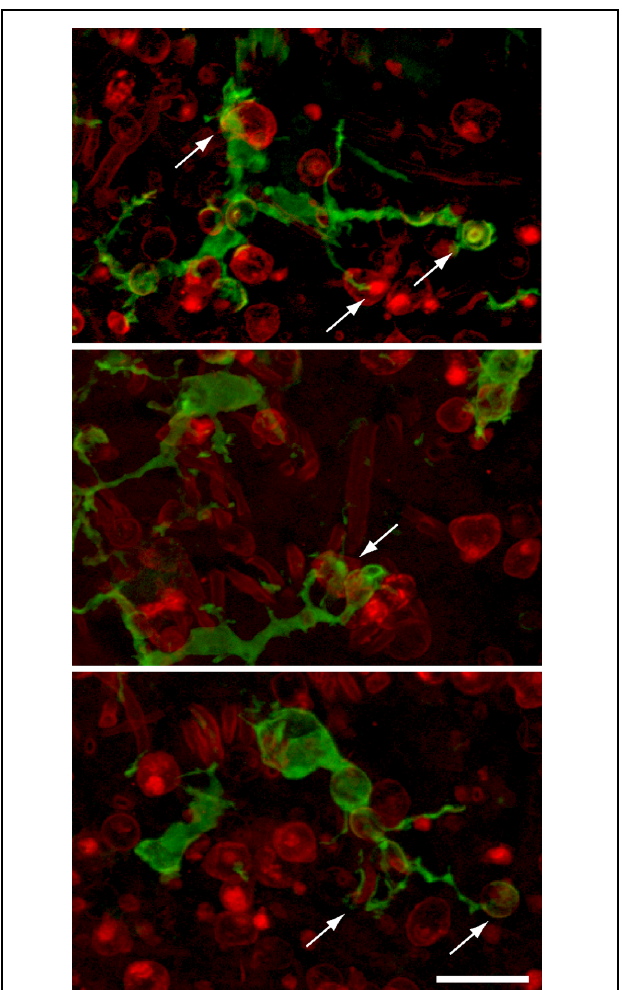
FIGURE 5 | Examples of GFP-expressing macrophages in the sensory epithelia of lesioned utricles. Processes of macrophages (green) frequently appeared to contact (arrows) immunolabeled hair cells (red, otoferlin), suggesting that apoptotic hair cells may attract macrophage pseudopodia. Scale bar = 20 µ